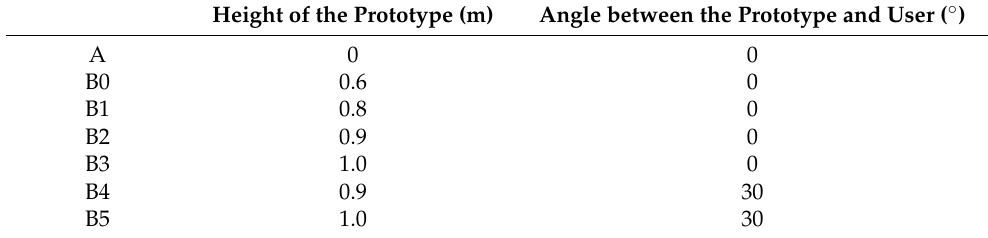
Table 5. Optimization design strategies.